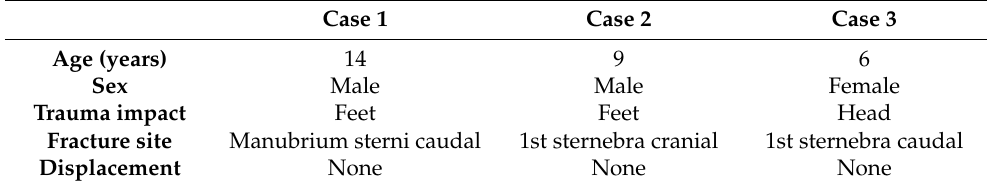
Table 1. Baseline characteristics and mode of injury of the three children suffering sternal